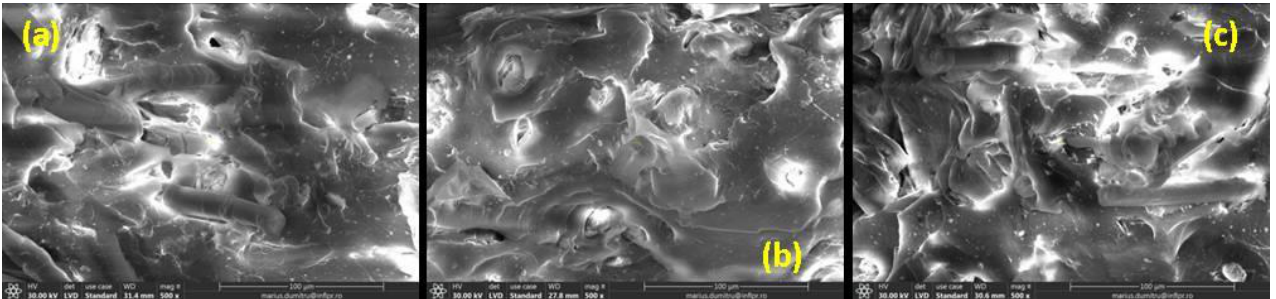
Figure 10. SEM micrographs of non-irradiated NR-H sample ( a ) and irradiated at 150 kGy ( b ) and 450 kGy ( c ) (magnification of 500).